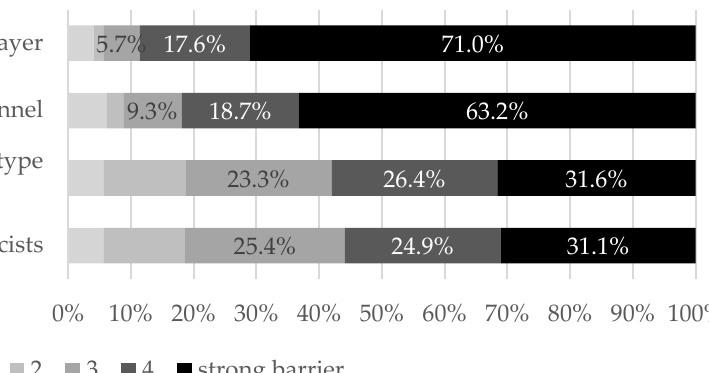
Figure 8. Assessment of obstacles to the introduction of the clinical pharmacy service.